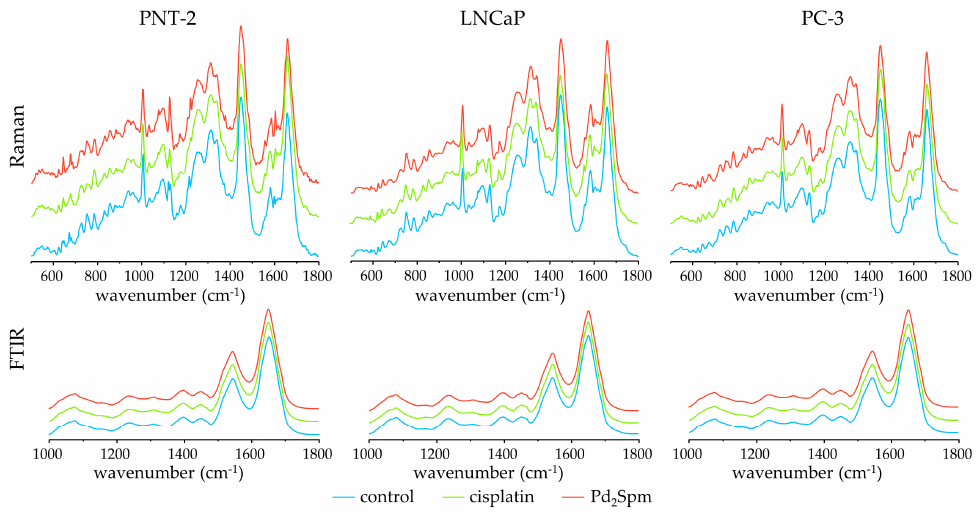
Figure 3. Mean Raman (500–1800 cm − 1 ) and infrared (1000–1800 cm − 1 ) spectra for untreated/control (blue line), cisplatin-treated (green line), and Pd 2 Spm-treated (red line) cells.